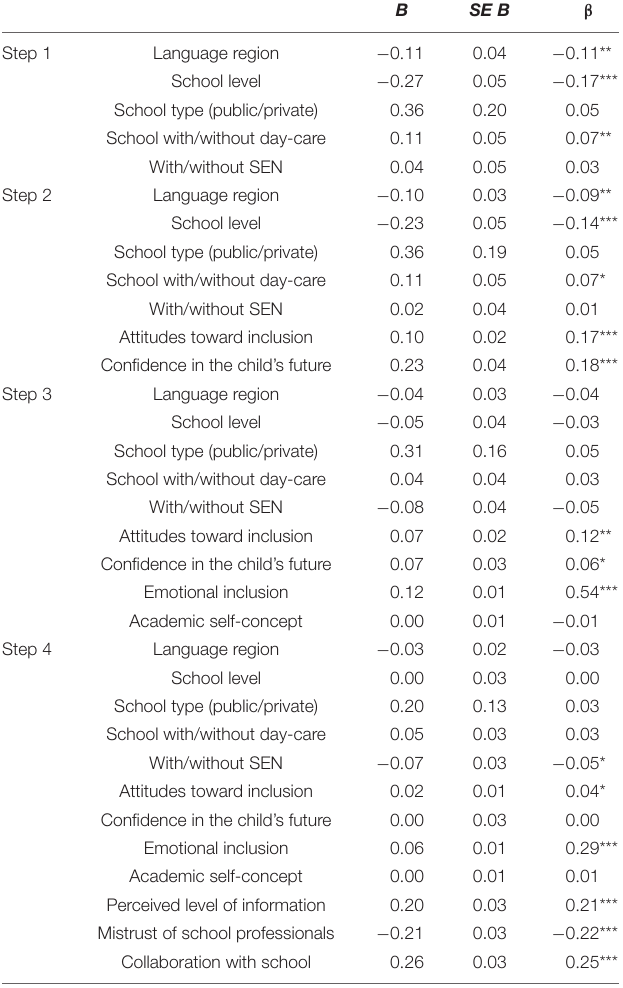
TABLE 1 | Multiple hierarchical regression analysis for parent’s general school satisfaction ( N =